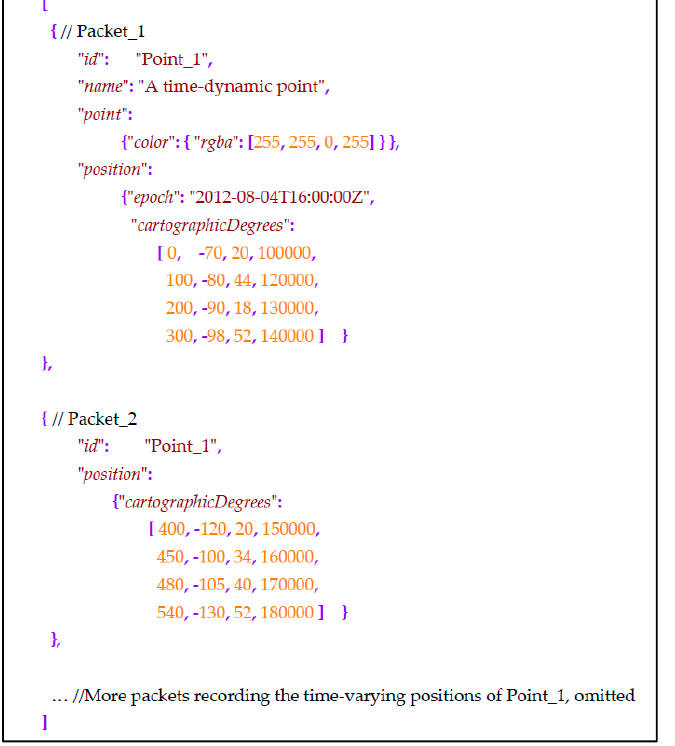
Figure 6. Example of distributing a CZML property into multiple packets to support streaming.